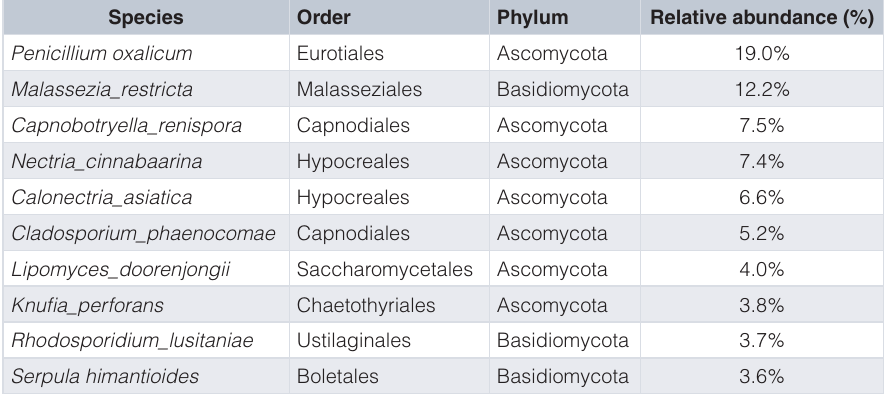
Table 4. Predominant fungi species identified from the nostrils of healthy medical students.